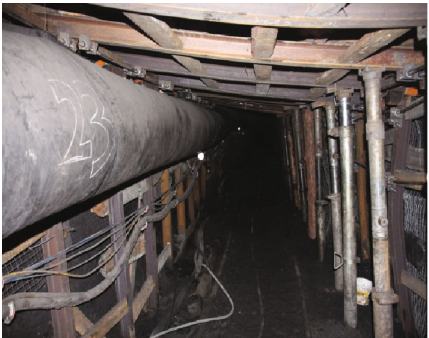
Figure 12: The stable reused roadway surrounding rock after roof